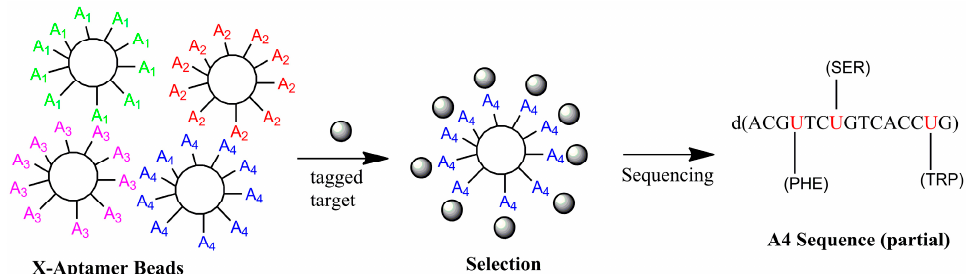
Figure 3. X-aptamer selection process using tagged proteins. Each aptamer bead contains many copies of a single X-aptamer. Beads are selected by fluorescence or magnets, and a second optional solution-phase selection step is not shown.